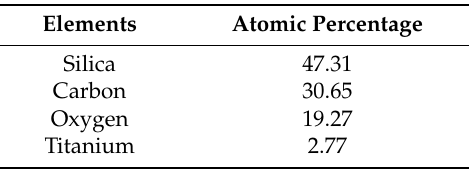
Table 1. Energy dispersive X-ray (EDX) analysis for element composition in (1) nanostructured titania-silica (Ti-SiNS).